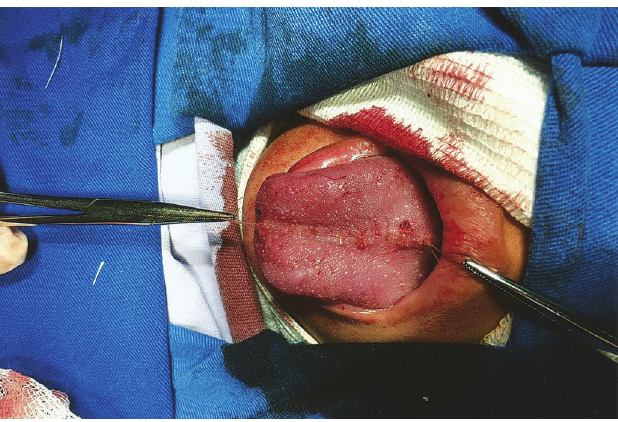
Figura 3 − Língua após ráfia/sutura da ferida operatória